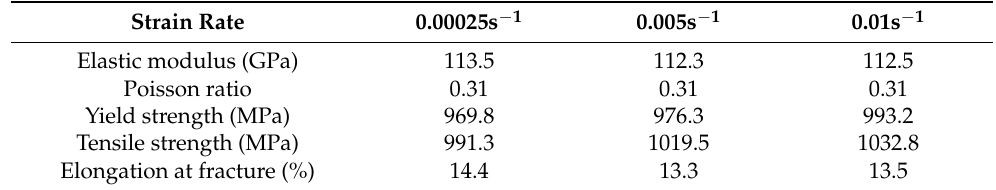
Table 2. Results of tensile test at room